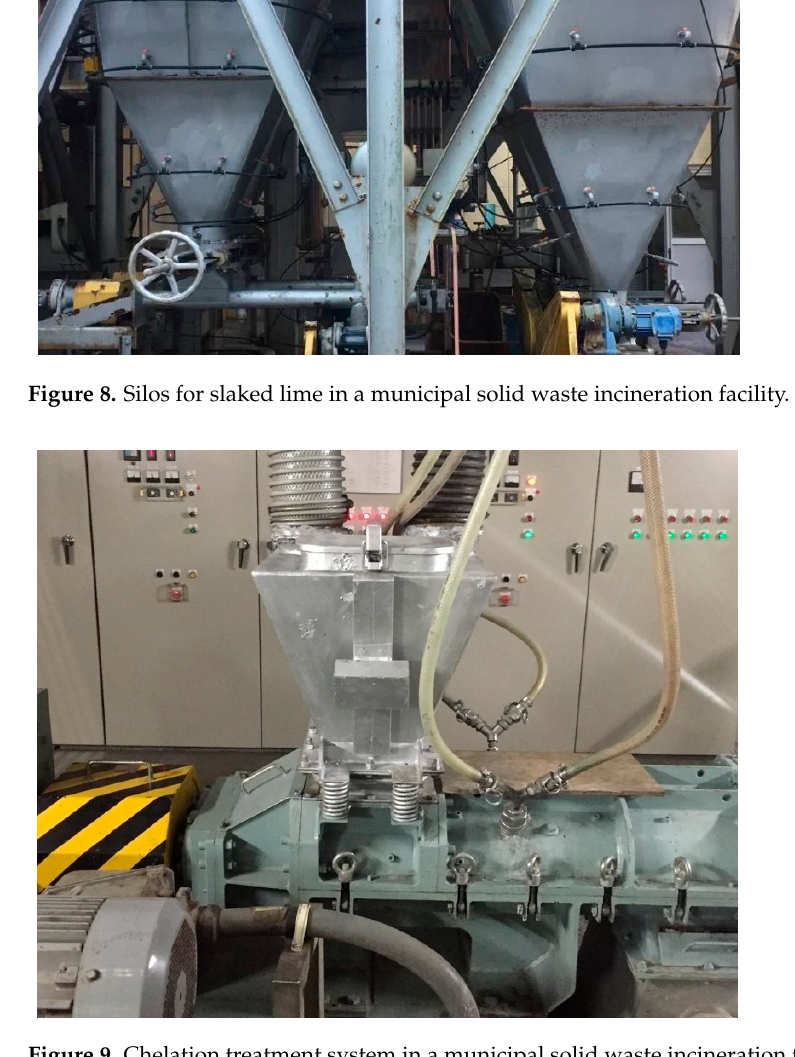
Figure 9. Chelation treatment system in a municipal solid waste incineration